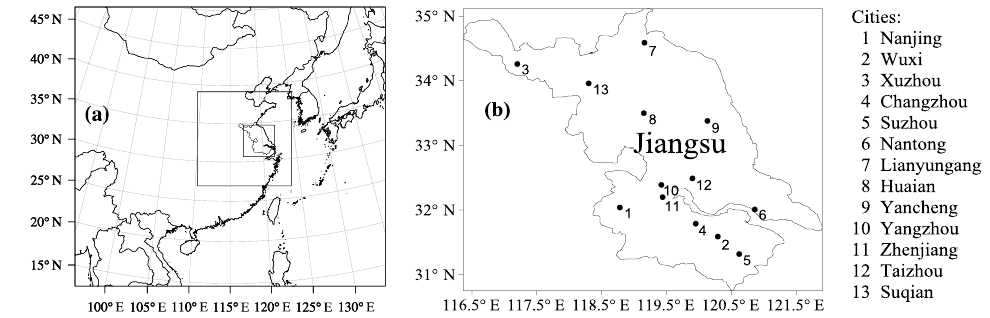
Figure 1. Model domain and the locations of the 13 cities in Jiangsu